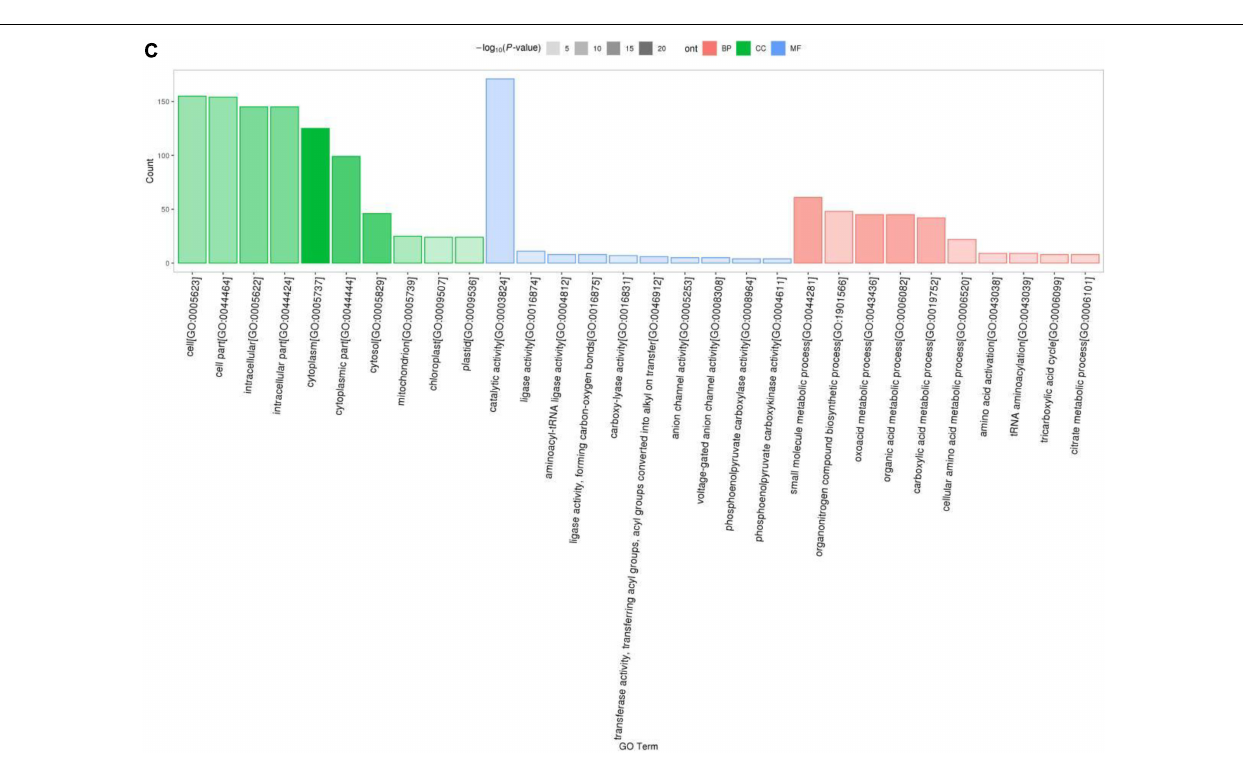
FIGURE 2 | GO enrichment analysis classification histogram of DEPs. The ordinate is the number of DEPs mapped, red indicates BP annotation information, green indicates CC annotation information, blue indicates MF annotation information, transparency indicates p- value size, the darker the color, the smaller the p -value. (A) P1 vs. P31; (B) P11 vs. P31; (C) P61 vs.